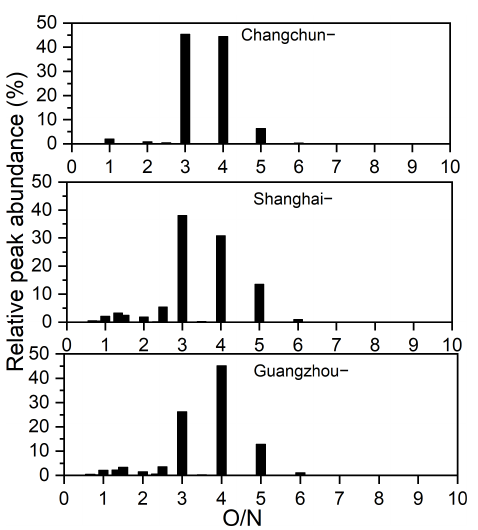
Figure 4. Classification of CHON- compounds into different sub- groups according to O / N ratios in their formulas. The y axis indi- cates the relative contribution of each specific O / N ratio subgroup to the sum of peak abundances of CHON- compounds.